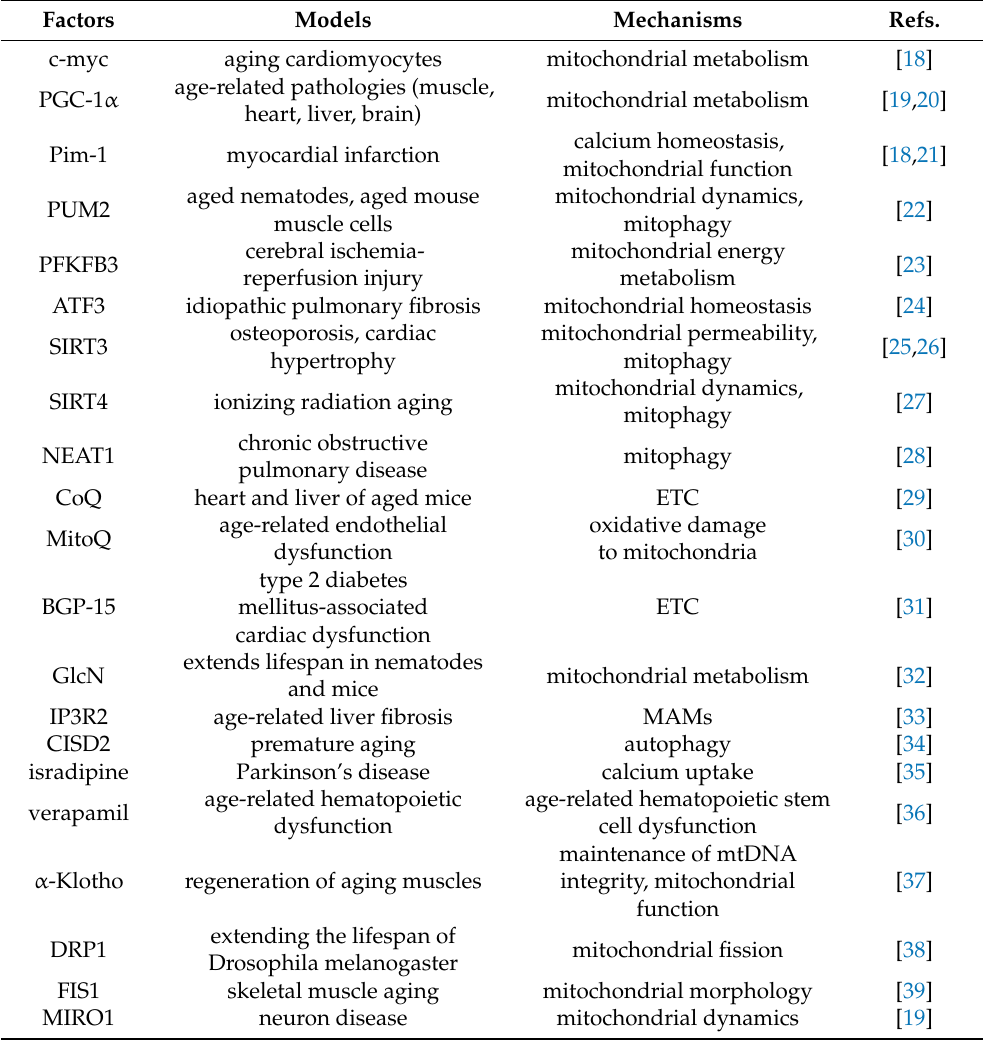
Table 1. Factors involved in age-related human mitochondrial diseases. Factors